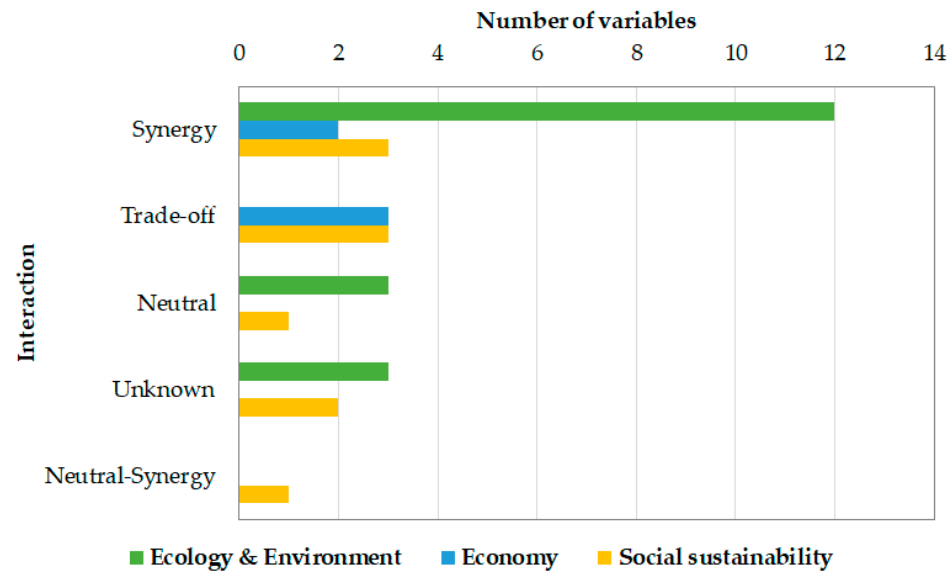
Figure 2. Interactions between sustainable development variables and energy performance divided into the three sustainability dimensions. N = 33 (Ecology & Environment N = 18; Economy N = 5; Social sustainability N = 10).